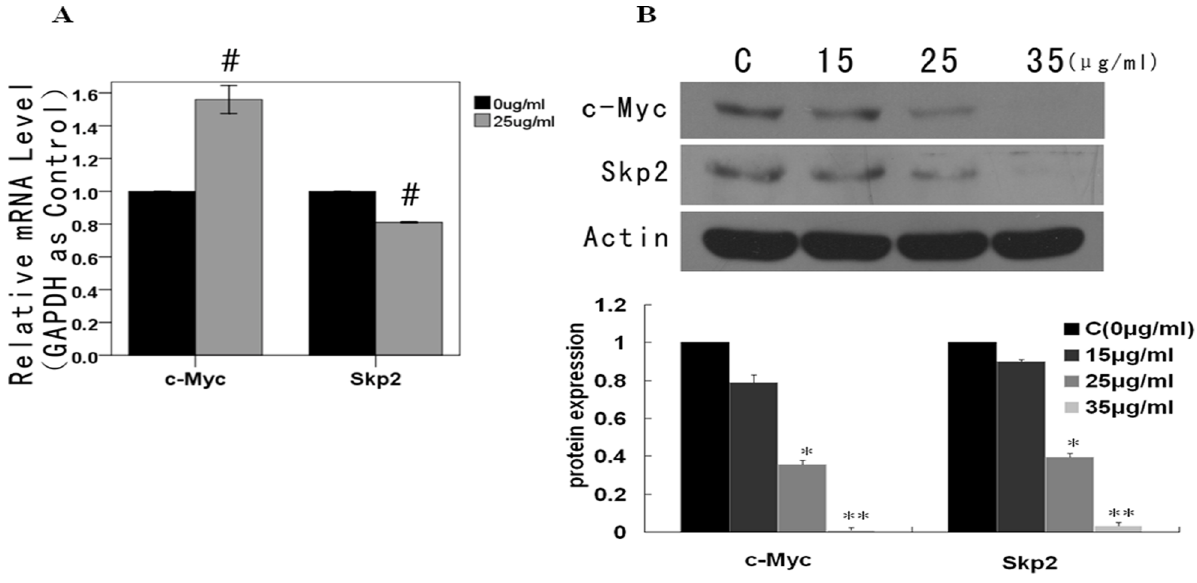
Figure 4. Effects of wogonin on c-Myc and Skp2 in A549. (A) Relative mRNA levels of c-Myc and Skp2 were detected using real-time PCR with GAPDH as an internal control. Results are expressed as the mean 6 SEM of five independent experiments. # P , 0.01 vs control group. (B) Protein levels of c-Myc and Skp2 assayed by western blot. In these experiments, cells were exposed to wogonin 0, 15, 25 and 35 m g/mL for 48 h. * P , 0.05 vs control group, ** P , 0.01 vs control group.